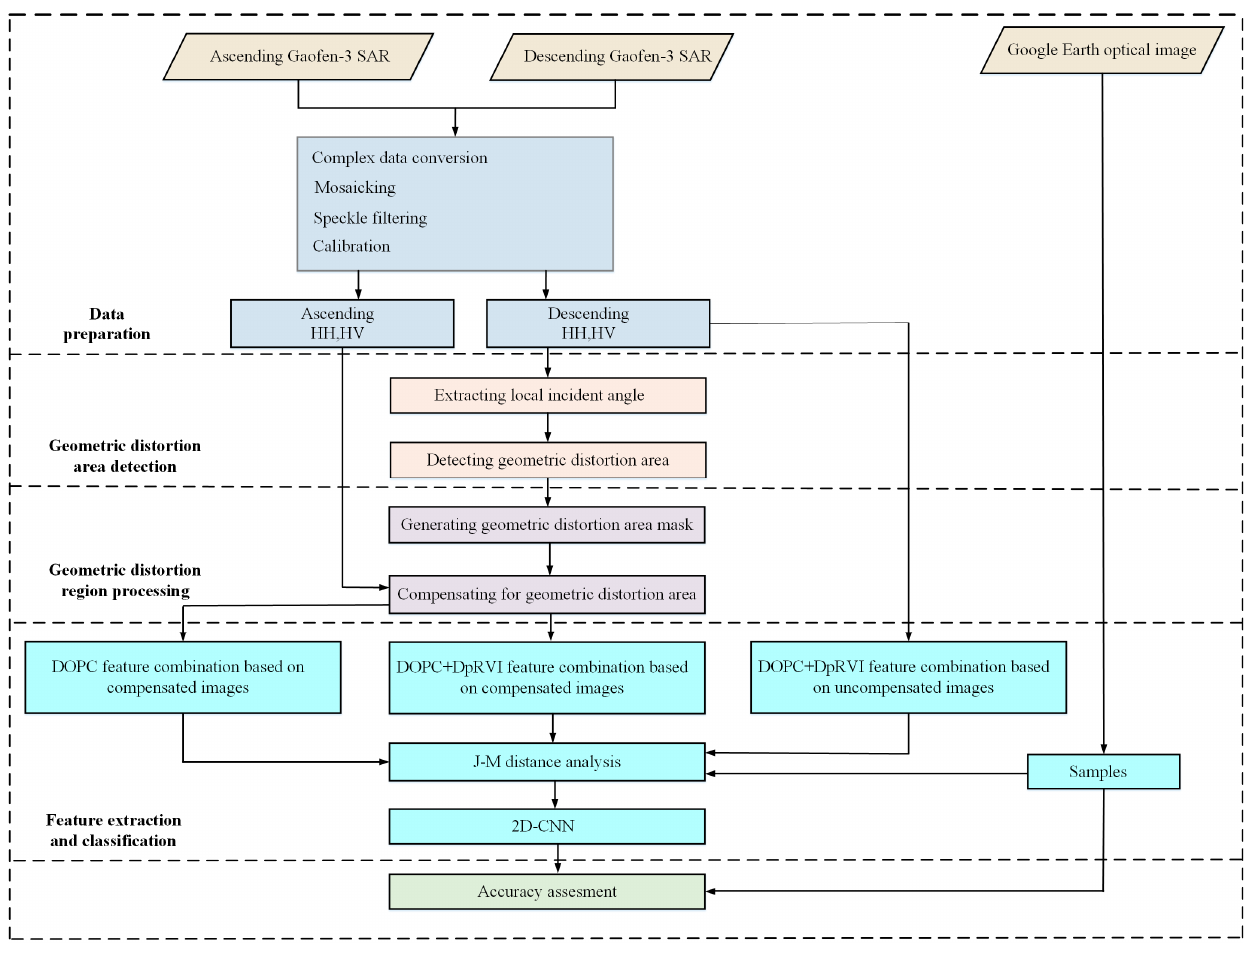
Figure 5. The f ramework of the proposed method. Figure 5. The framework of the proposed